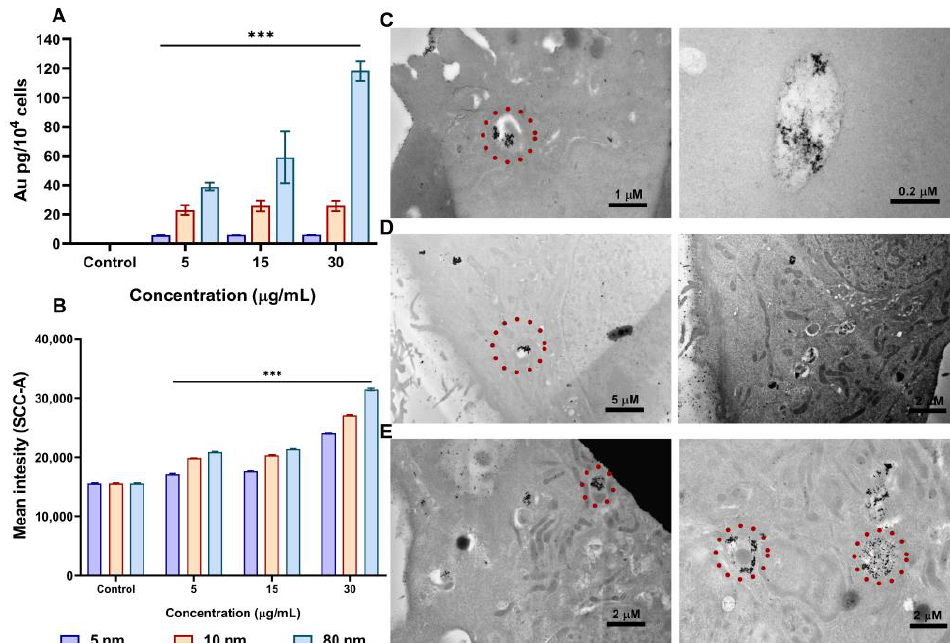
Figure 3. Cellular uptake of different sizes of AuNPs in A549 cells after 24 h incubation. ( A ) The Au content in A549 cells measured with inductively coupled plasma mass spectrometry (ICP-MS) ( B ) Side scatter (SSC) intensity changes due to the uptake of AuNPs analysed using flow cytometry. TEM Images of the internalisation of AuNPs into A549 cells after treatment with 30 µg/mL for 24 h of ( C ) 5 nm, ( D ) 10 nm, and ( E ) 80 nm AuNPs. AuNPs are indicated by circles. Plotted graphs represent the means ± SD of three independent experiments. Bars with an asterisk (*) show a statistical difference (*** p < 0.001) when compared with the control.